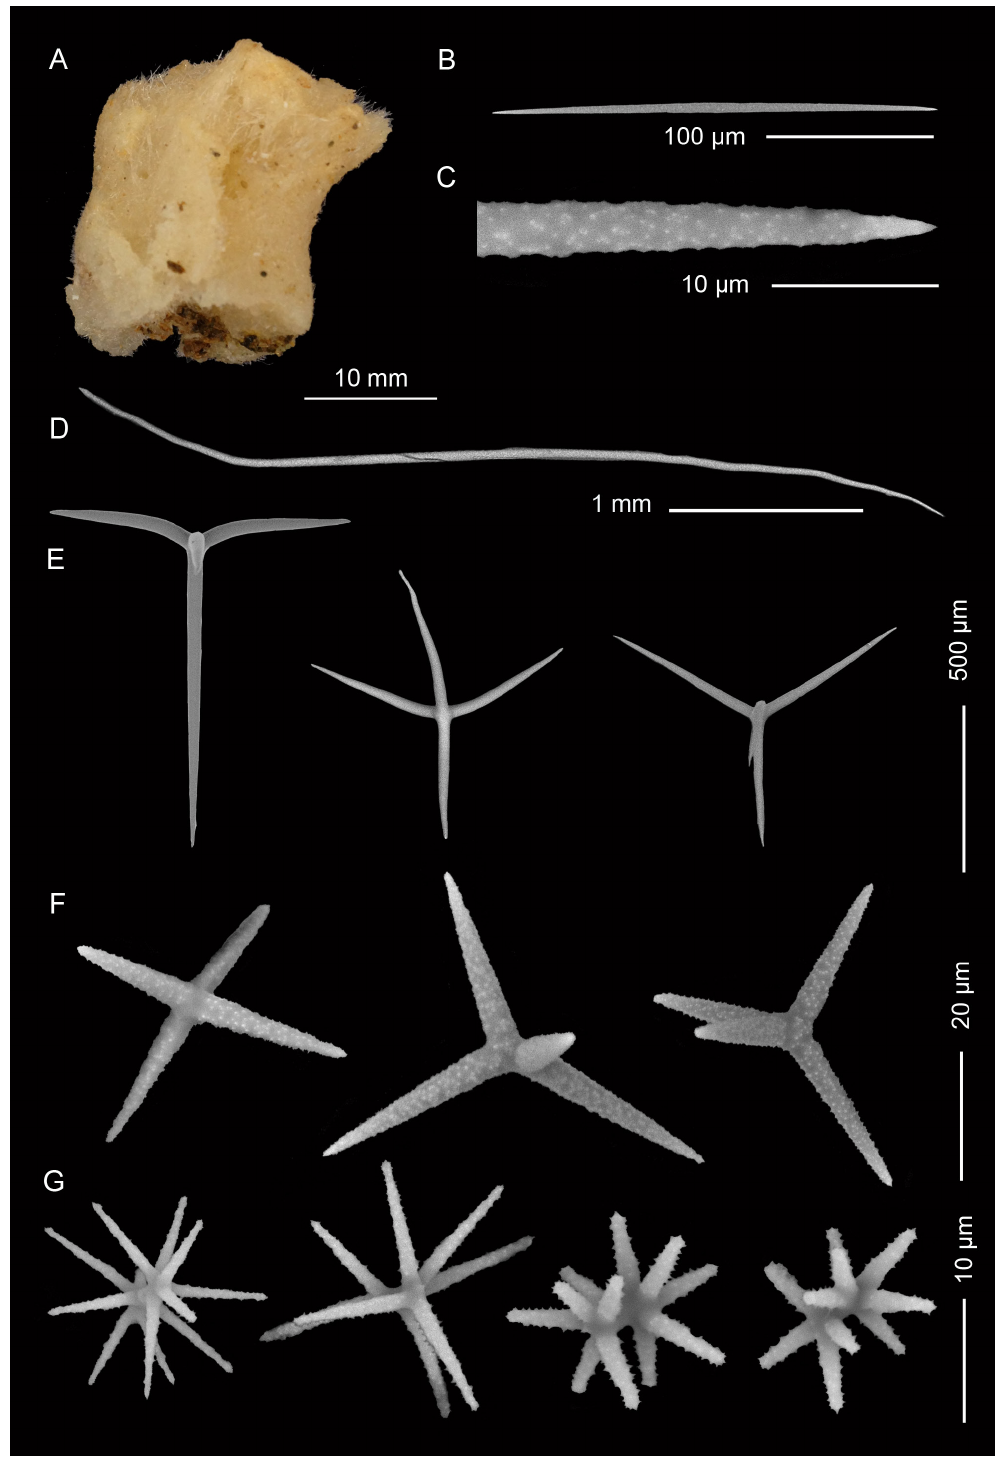
Fig. 5. Morphology, megascleres and microscleres of Poecillastra macquariensis Kelly & Cárdenas sp. nov. (NIWA 52640 leg., holotype). A . Stalk, showing smooth attachment base with specks of remaining substrate, and broken edge of the upper part of the sponge. B . Microxeas. C . Detail of microxea showing roughened surface. D . Contort oxea of choanosome. E . Range of triaenes with medium to short shafts (calthrops). F . Plesiasters. G . Spiraster to metaster-like